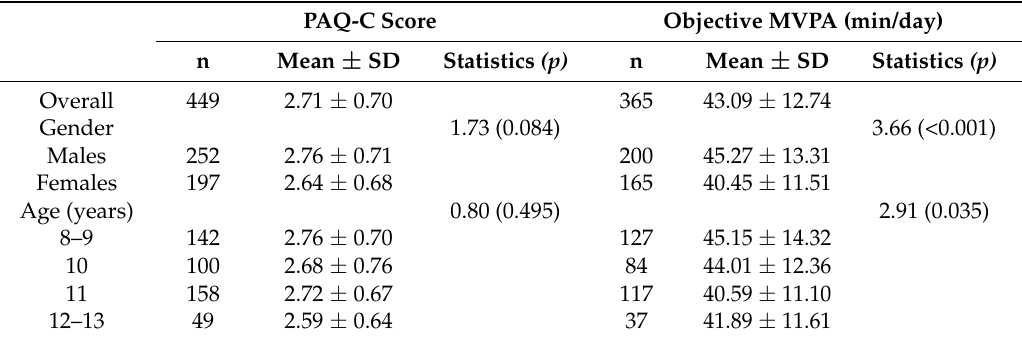
Table 1. Physical Activity Behaviors among Different Gender and Age Groups.